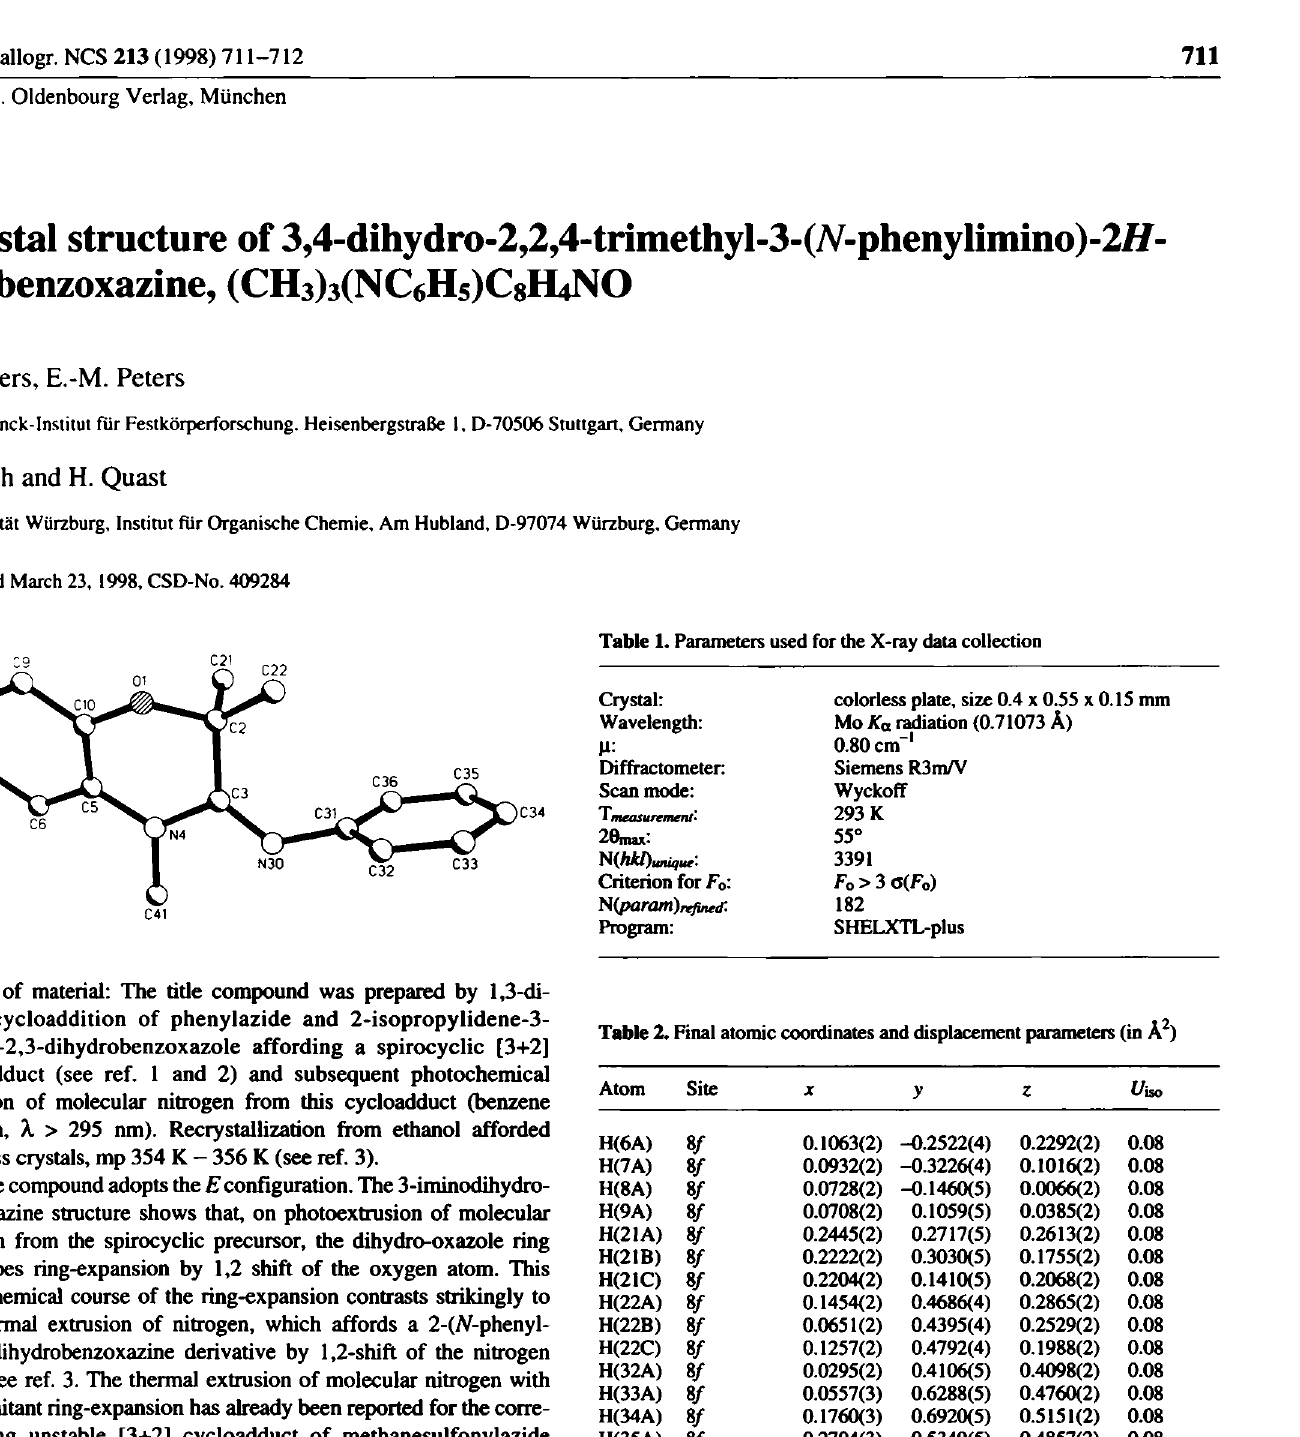
Table 3, Final atomic coordinates and displacement parameters (in A^)